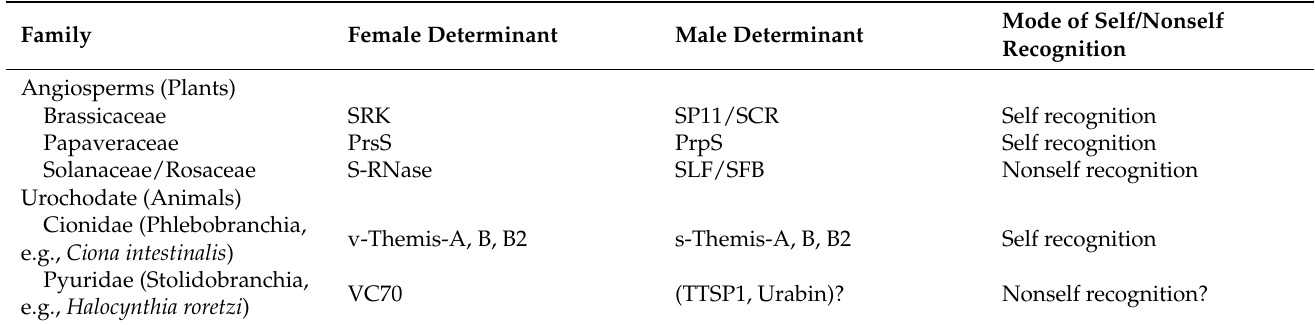
Table 2. Male and female determinants in self-incompatibility of plants and